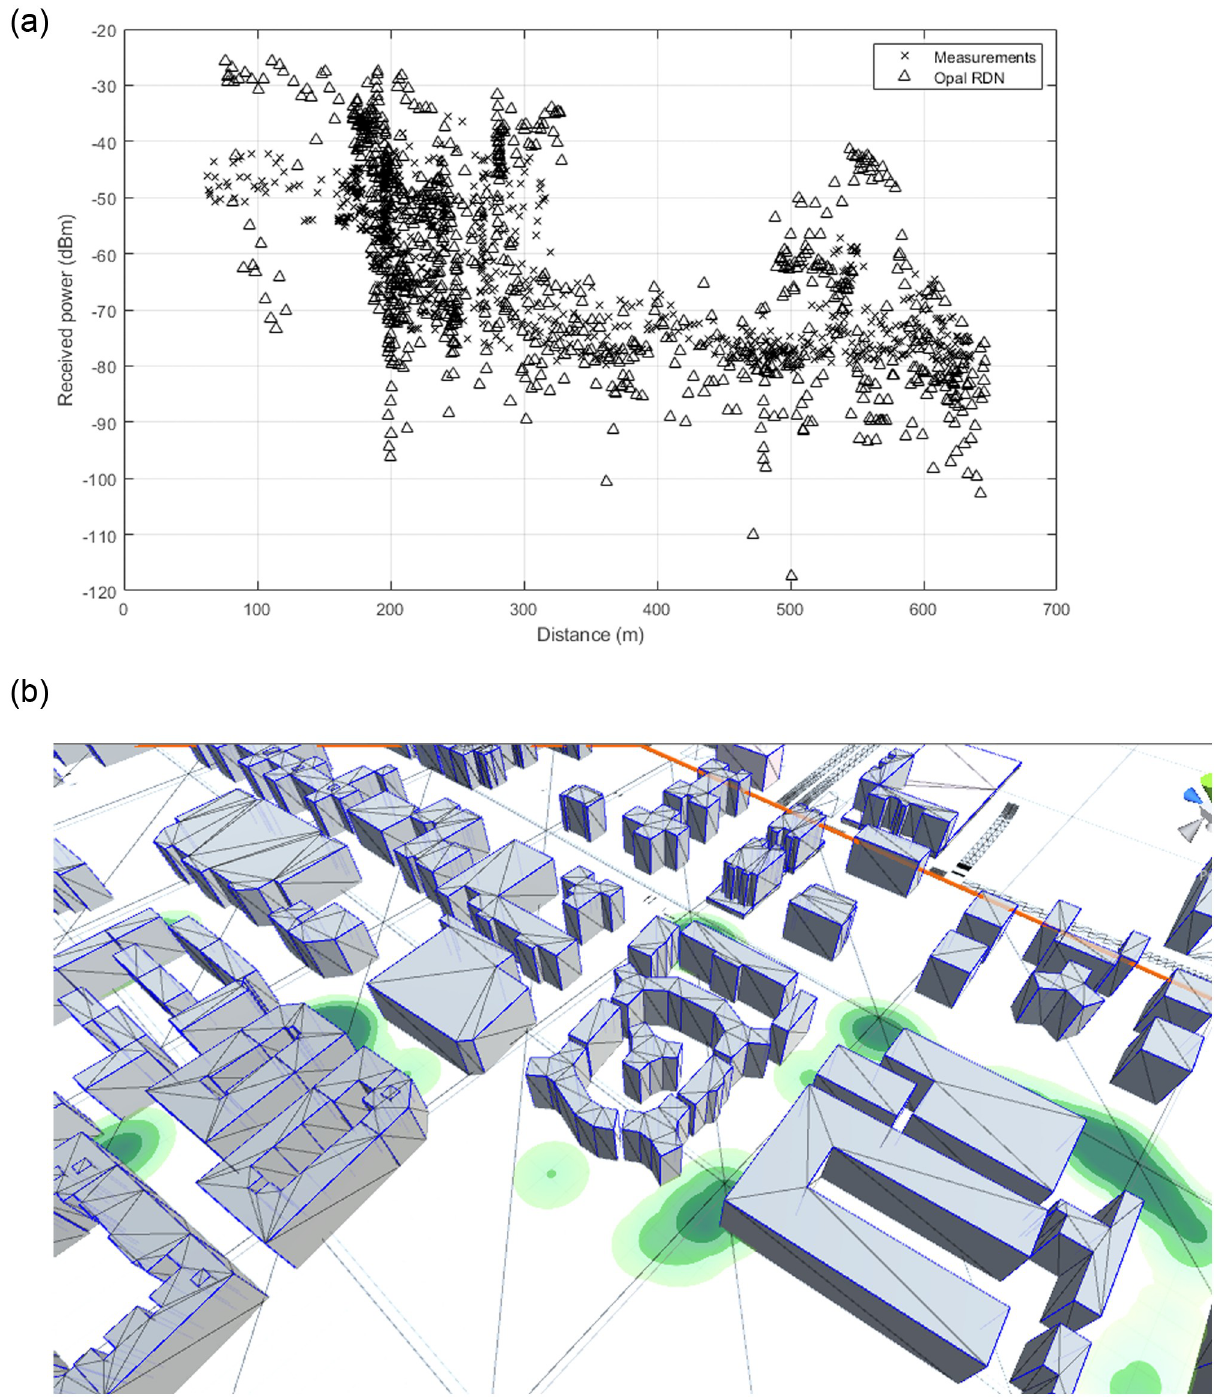
Fig 10. Comparison of measurements at 1.8 GHz and simulation in the city of Cartagena. The generated scenario includes 1067 buildings and 15082 diffraction edges. 898 receivers were simulated simutaneously. Each simulation point show the average of 10 replications. (a) Urban measurements. (b) Snapshot of a heatmap of the received EM